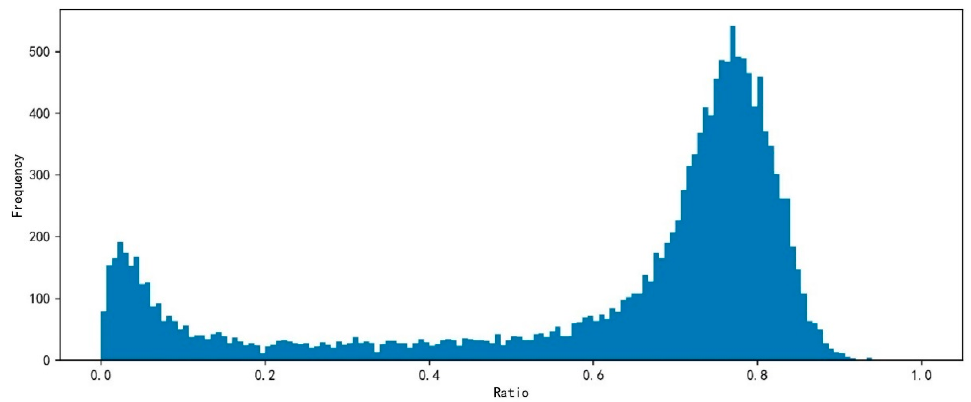
Figure 6. Histogram of LWR results.